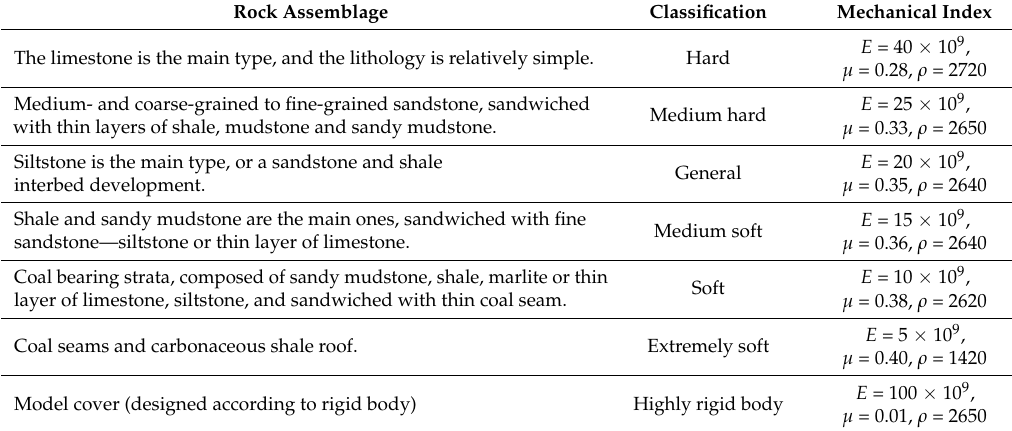
Table 2. Classification of rock assemblage types and calculation parameters of the simulation in the research